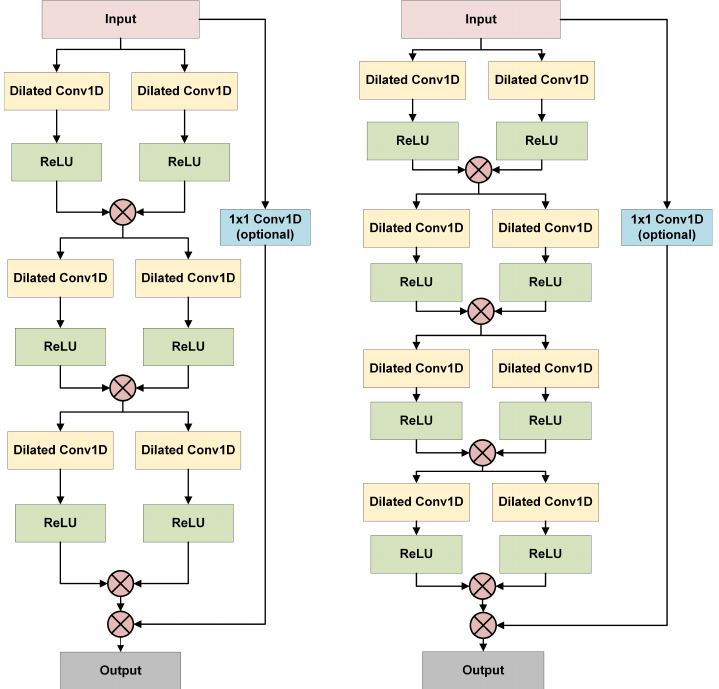
Figure 2. Residual Block 1 ( left ). Residual Block 2 ( right